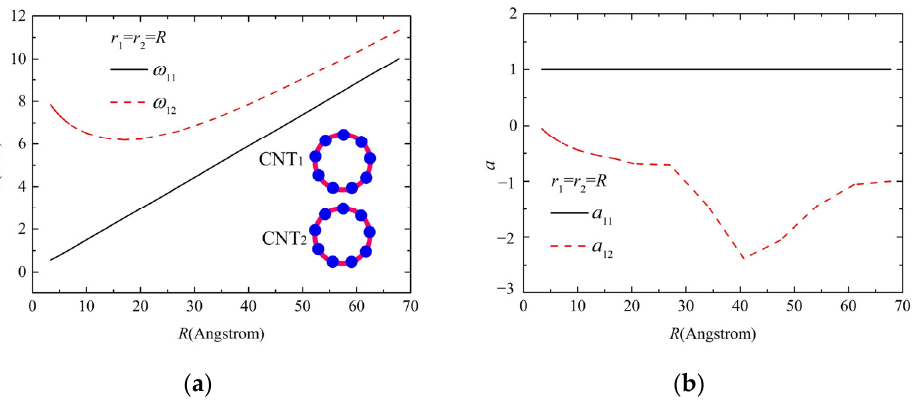
Figure 5. Vibration of the two parallel CNTs with the same diameter: ( a ) the resonance frequency and ( b ) amplitude ratio of CNTs.